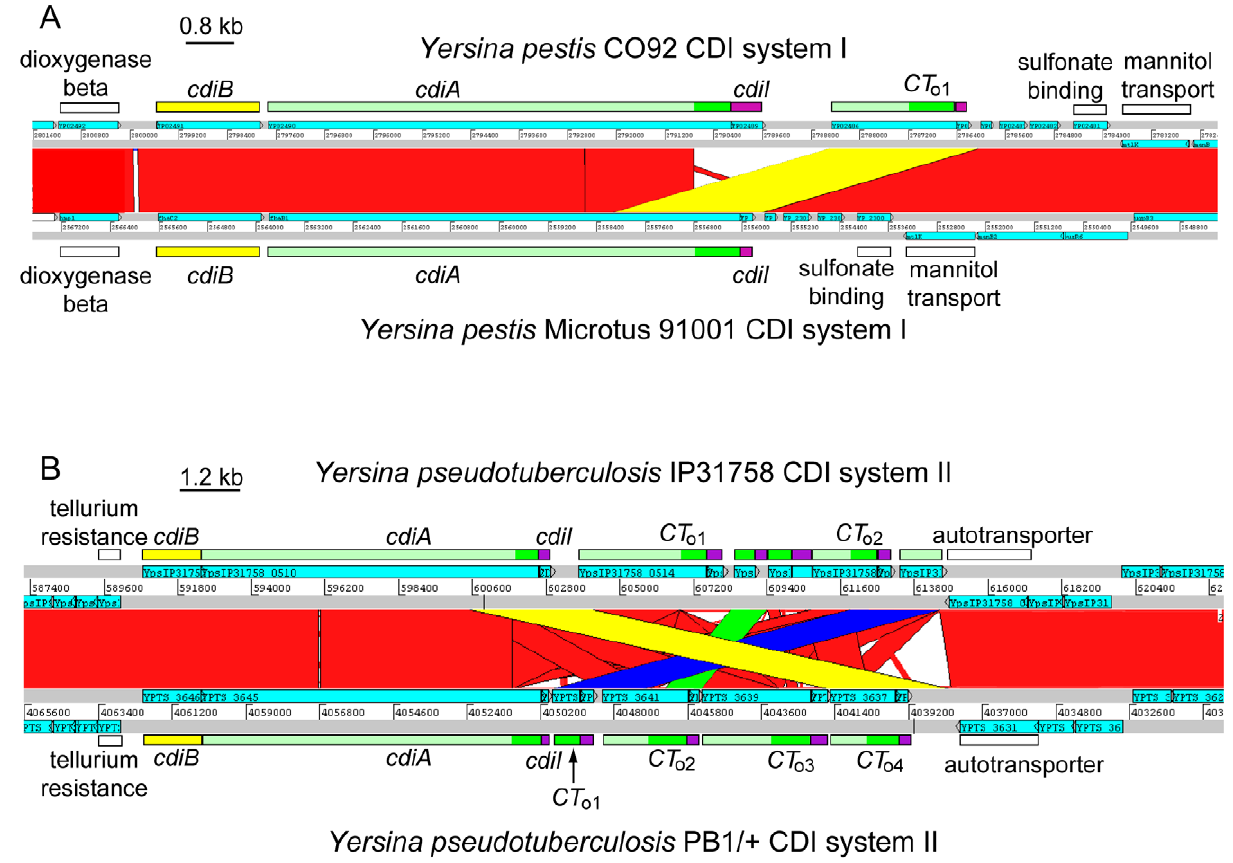
Figure 3. Interchange between cdiA and orphan cdiA-CT s. A) ACT comparison of the CDI systems (region I) from Y. pestis CO92 (top) and Y. pestis Microtus 91001 (bottom). The cdi loci lie within a highly conserved genomic region (red blocks denote nucleotide conservation), but the sequences encoding CdiA-CT diverge beginning at the VENN region. A 3,557 bp deletion in Y. pestis Microtus 91001 has fused the orphan cdiA-CT/cdiI module to the full-length cdiA gene (highlighted in yellow). B) ACT comparison of region II cdi loci from Y. pseudotuberculosis strains IP31758 (top) and PB1/ + (bottom). The cdi loci lie within a highly conserved genomic region (red denotes nucleotide conservation), but the cdiA-CT sequences exhibit complex rearrangements between the two strains. The orphan cdiA-CT o4PB1(II) / cdiI o4PB1(II) module of strain PB1/ + is essentially identical to the cdiA-CT IP31758(II) and cdiI IP31758(II) sequences from strain IP31758 (99.1% identity over 3,648 nucleotides; highlighted in yellow). Additionally, the orphan cdiA-CT o1PB1(II) / cdiI o1PB1(II) module is nearly identical to the orphan cdiA-CT o2IP31758(II) / cdiI o2IP31758(II) module (98% identity over 2,656 nucleotides, highlighted in blue), and the cdiA-CT o2PB1(II) / cdiI o2PB1(II) module is nearly identical to a cdiA fragment (and associated cdiI gene) found between the two orphan modules in strain IP31758 (98% identity over 1,073 nucleotides; highlighted in